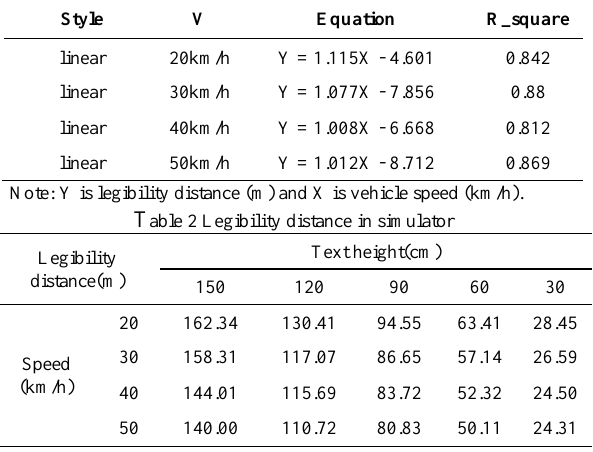
Fig.10. Text height and legibility distance relationship at speed 50km/h Table 1 Regression model in virtual